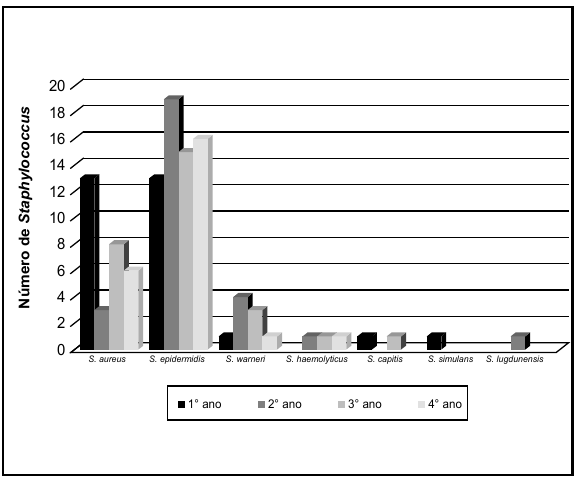
Figura 2 – Perfil de resistência à oxacilina em S. aureus e espécies de ECN isoladas das fossas nasais de alunos do curso de enfermagem da FMB ECN: estafilococos coagulase-negativos; FMB: Faculdade de Medicina de